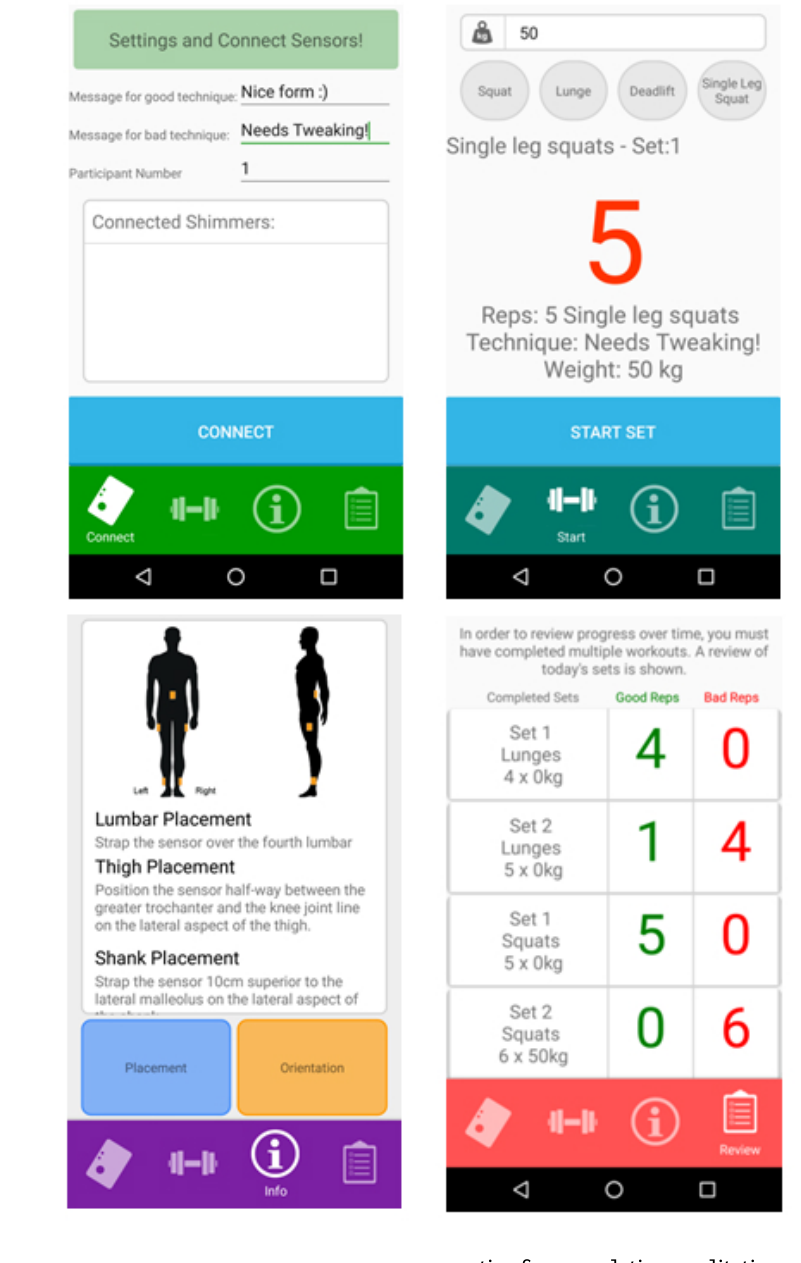
Figure 1. The Formulift app. User preferences and connecting to the inertial measurement unit (IMU; top left), real-time exercise biofeedback (top right), information and instructions (bottom left), and workout review (bottom